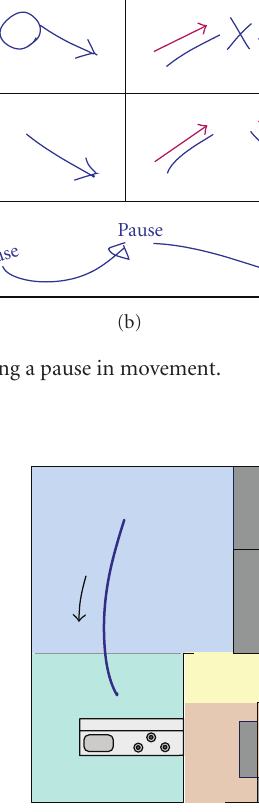
Figure 10: Type 2 query for movement from living room to the